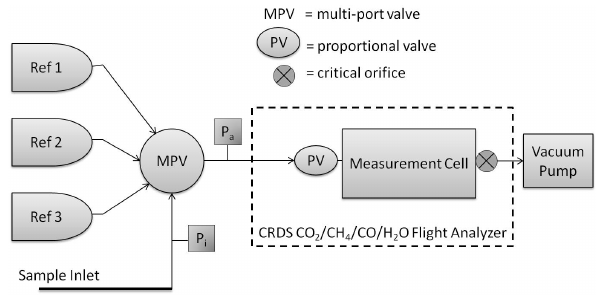
Fig. 3. Schematic diagram of CO 2 /CH 4 /CO/H 2 O sampling system on the C-130